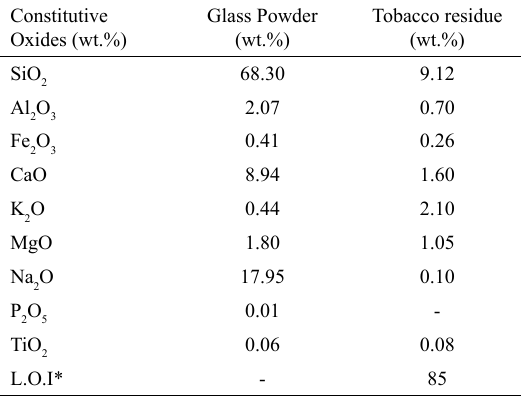
Table 1. Chemical composition of bottle glass powder and Tobacco residue. Constitutive Oxides (wt.%)